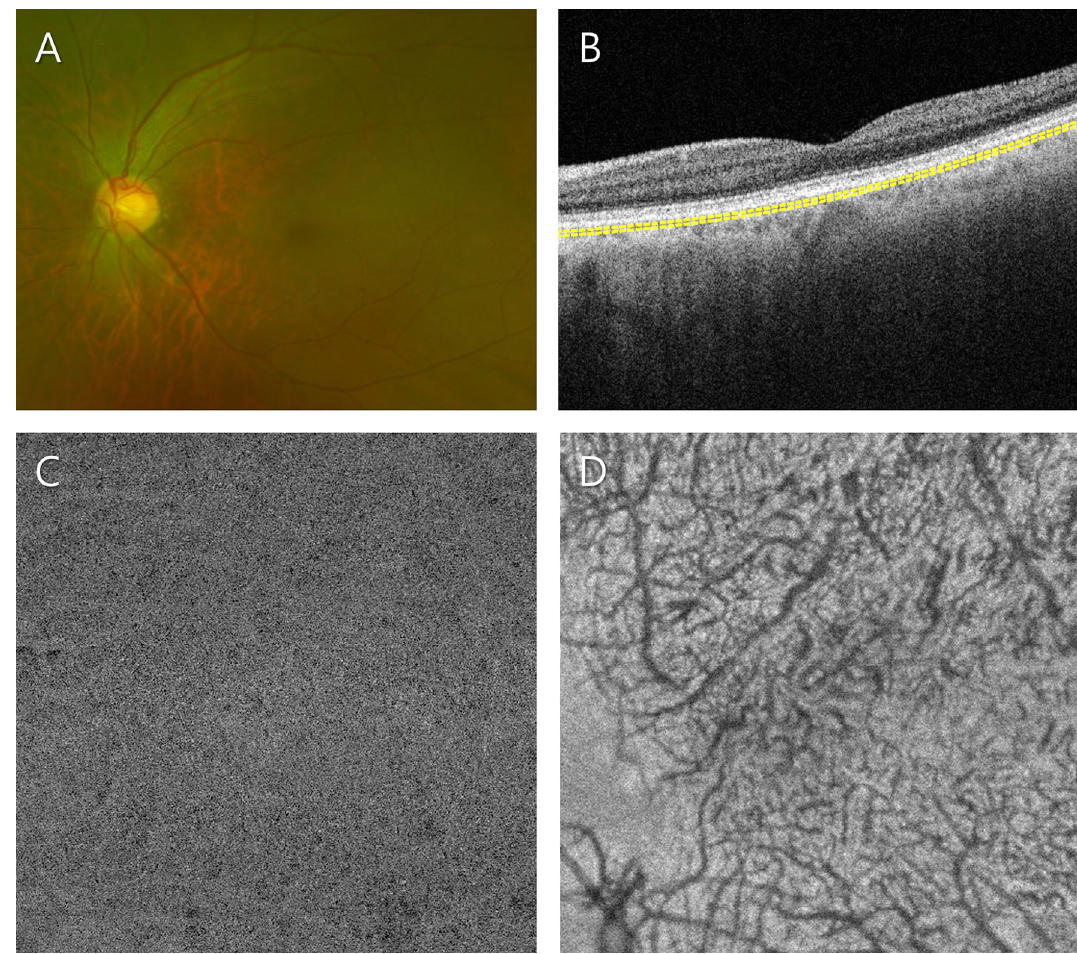
Figure 1. Representative subject in the healthy control group. ( A ) Ultra-widefield fundus photograph showing no specified lesions. ( B ) Optical coherence tomography (OCT) B-scan image showing no pathological changes. The subfoveal choroidal thickness was 153 µm. Slab to acquire the choriocapillaris (CC) flow is depicted as a yellow dashed line. ( C ) OCT angiography (OCTA) image of the CC. Relatively small flow voids were evenly distributed throughout the scanned area. The average size, number and total area of the flow voids were 221.1 µm 2 , 27,209, and 6.0 mm 2 , respectively. ( D ) Structural en face OCT image of the Haller layer. The mean and standard deviation of the Haller vessel diameter were 73.8 and 31.3 µm,